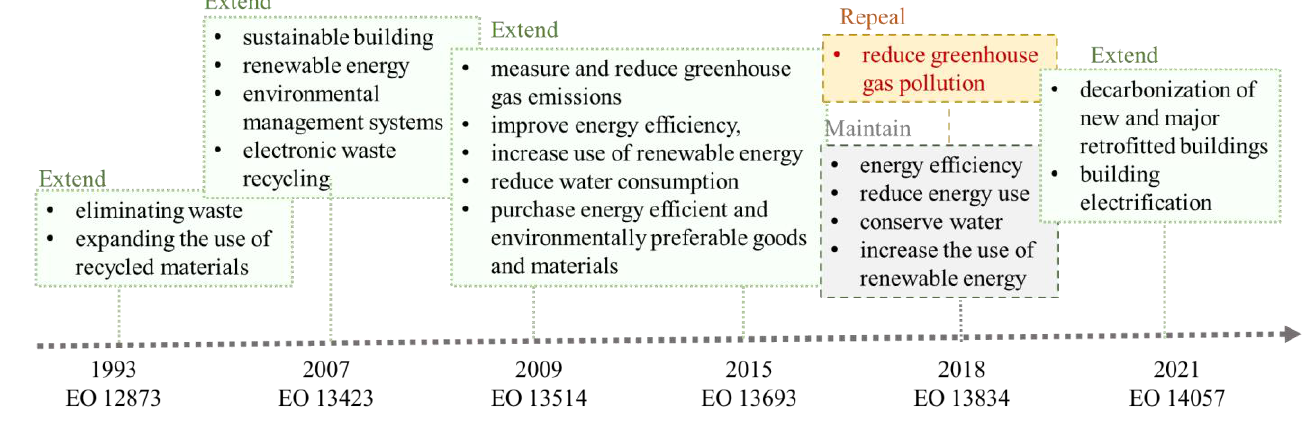
Figure 3. Changes in policies and regulations related to ZCBs in the United States.